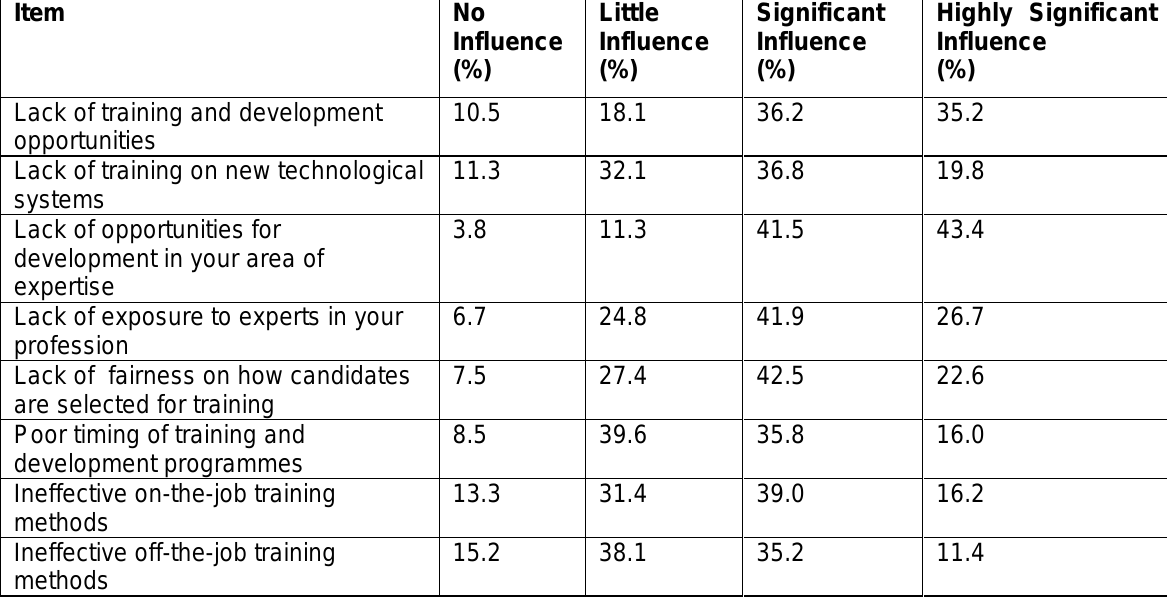
Table 7: Perceived i nfluence of training and development strategy on the respondents’ consideration to